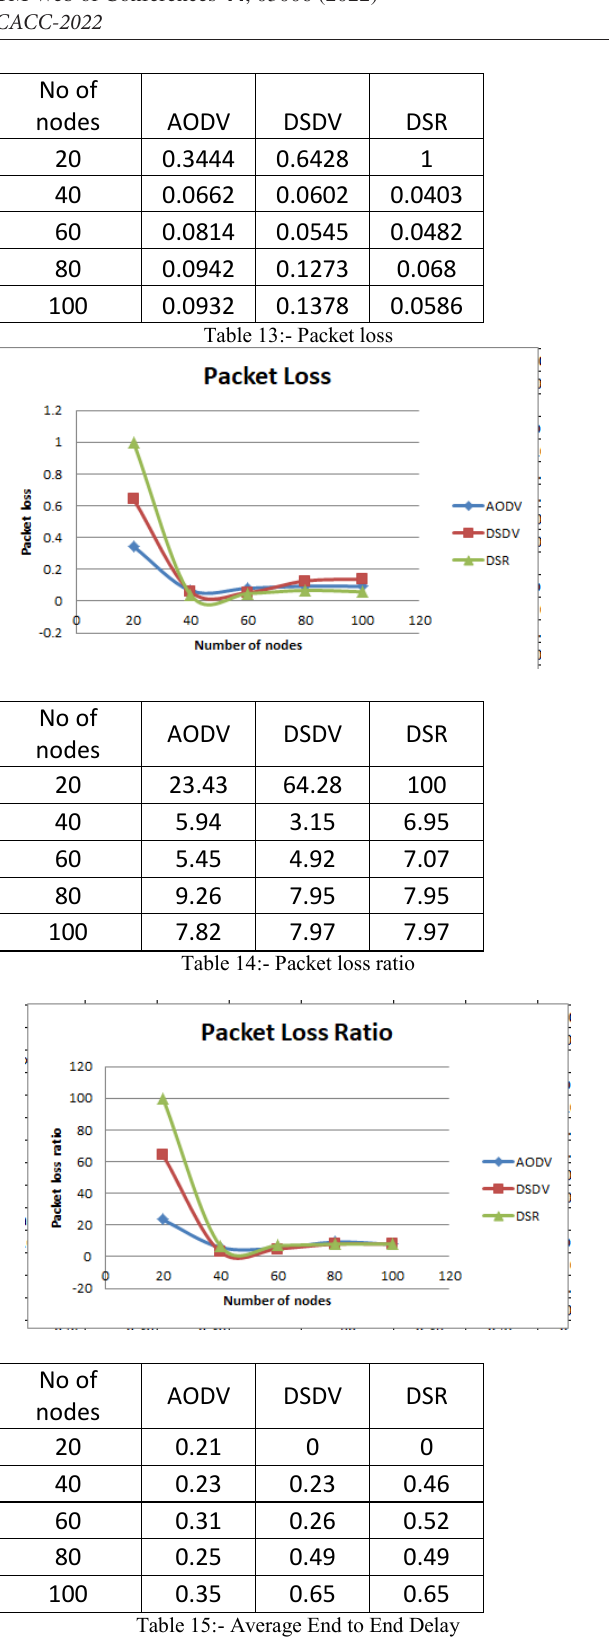
Table 14:- Packet loss ratio